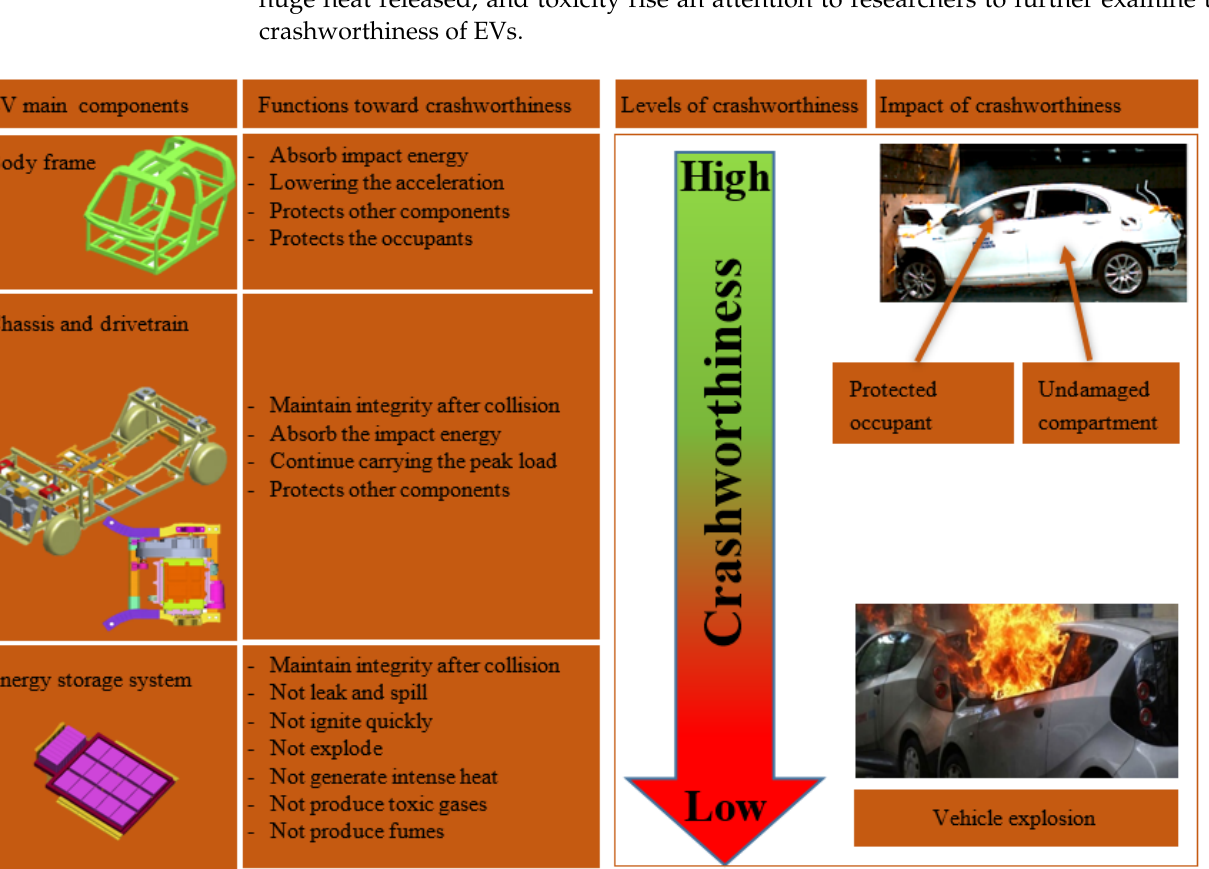
Figure 1. Examples of EV main components, their functions to enhance crashworthiness, and impact of the crashworthiness on EVs. The body frame and chassis are from Liu et al. [30] with permission from Elsevier, the drivetrain and energy storage system are from Navale et al. [29], with permission from Taylor & Francis. The impacts of the levels of crashworthiness are displayed on the right images as an example. The EV shown on the top right is from Yu et al. [31], with permission from Elsevier, and on the right bottom is from Science Focus [32].